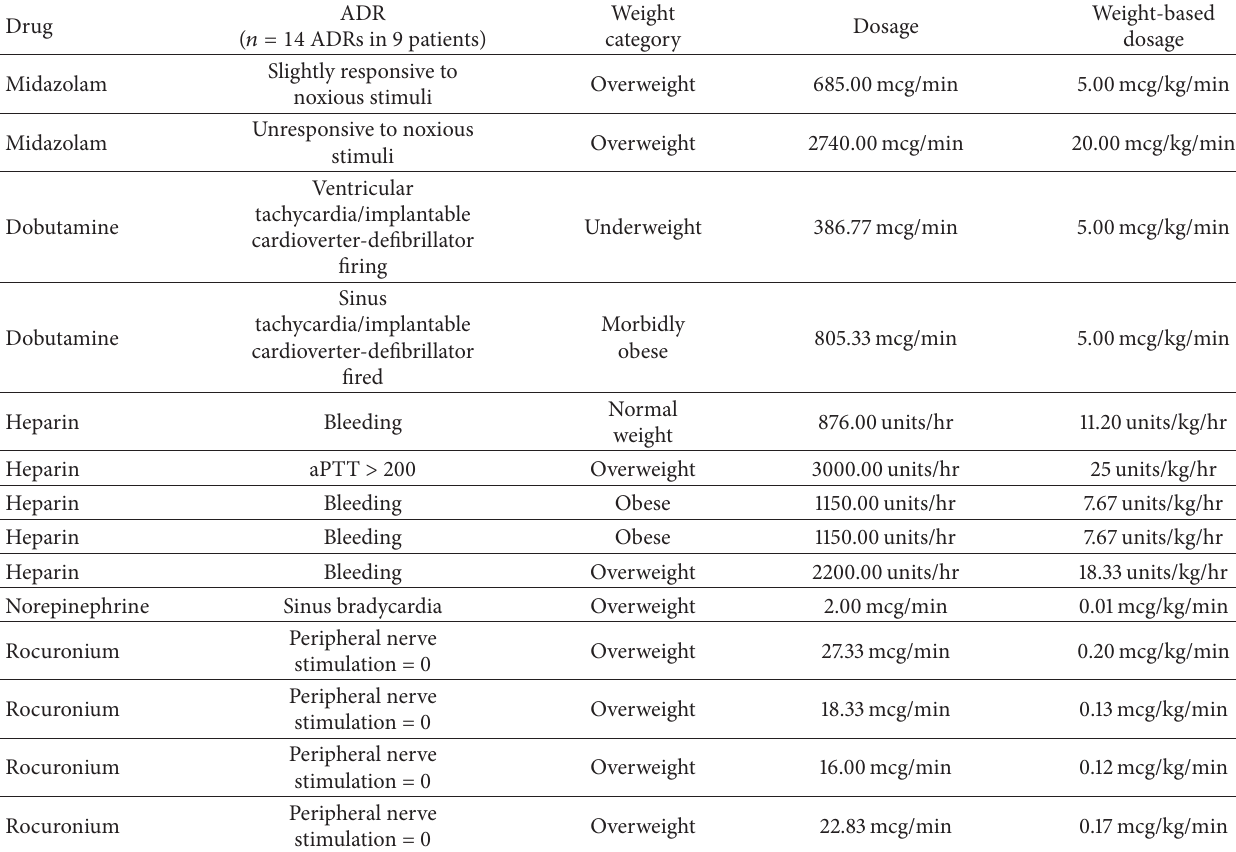
Table 4: Adverse drug reactions